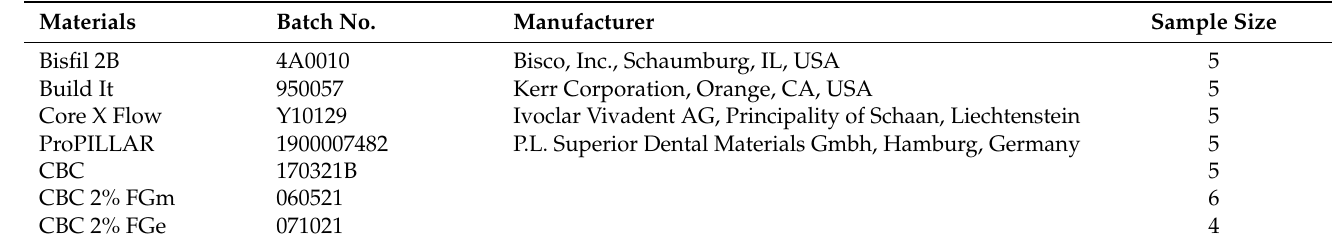
Table 3. Materials submitted to the flexural strength